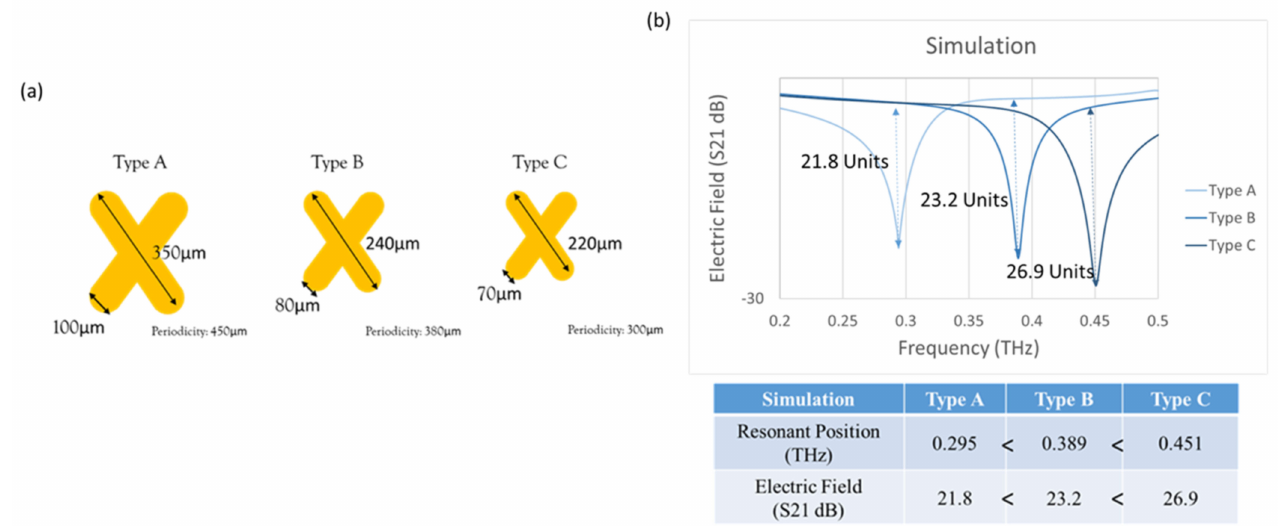
Figure 3. ( a ) Schematic diagram. ( b ) Simulated resonance position of three XPS pattern